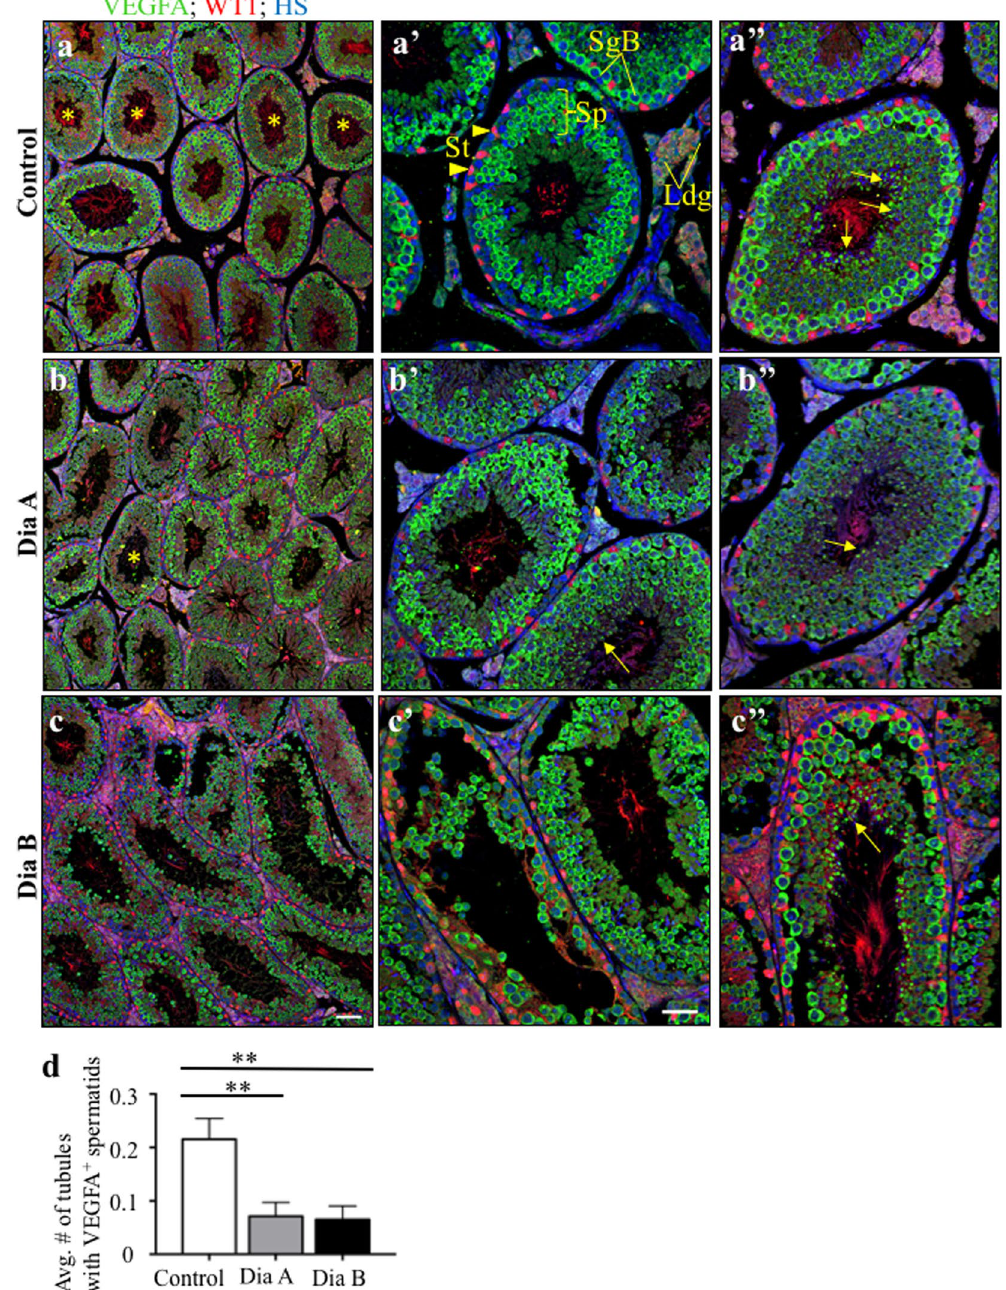
Figure 4. The number of the seminiferous tubules containing VEGFA + spermatids was reduced in the diabetic mice. ( a ) The representative images show the expression of VEGFA (green) and WT1 (red), a marker of Sertoli cells, in various stages of spermatogenesis, the seminiferous tubules with VEGFA + spermatids indicated by asterisks. ( a’ ) Detail of the seminiferous tubule with strong VEGFA expression in type B spermatogonia and primary spermatocytes and ( a” ) the tubule with VEGFA + spermatids (arrows). ( b – b” ) Representative images of the expression patterns of VEGFA and WT1 in the testes of diabetic group A (Dia A). ( c – c” ) The disruption of the epithelium in the seminiferous tubules is apparent in the testes of diabetic group B (Dia B), although the tubules with VEGFA + spermatids are present (arrow). Nuclei are counterstained with Hoechst 33342 (blue). Scale bar 100 μ m ( a , b , c ) and 50 μ m ( a’ – c” ). ( d ) The average number of the seminiferous tubules with VEGFA + spermatids. The values represent means ± SEM ( n = 3 individuals/6 sections/137 tubules/control group; 209 tubules/Dia A; 157 tubules/Dia B). ** P < 0.01 vs . Control by Dunnett’s post hoc tests. St, Sertoli cells; SgB spermatogonia type B; Sp, primary spermatocytes; Ldg, interstitial Leydig